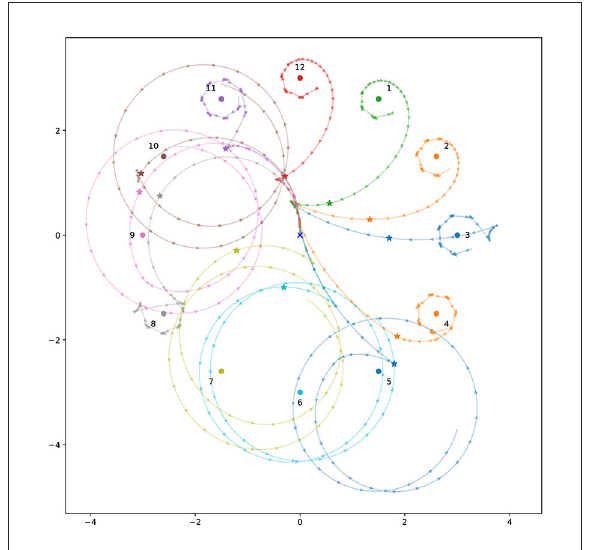
FIGURE7 Two distinct types of orbits are visible in the spatial trajectories for the best individual from populations evolved with sigmoidal interference (Equation 12). Type 1 orbits, reminiscent of the ancestral solution, are seen for Lights 11, 12, 1, 2, 3, and 4. Type 2 orbits, which feature a forward moving, counter-clockwise orbit of the light are seen for Lights 5, 6, 7, 9, and 10. For Light 8, an approach typical of a Type 2 orbit instead puts the robot in position for a Type 1